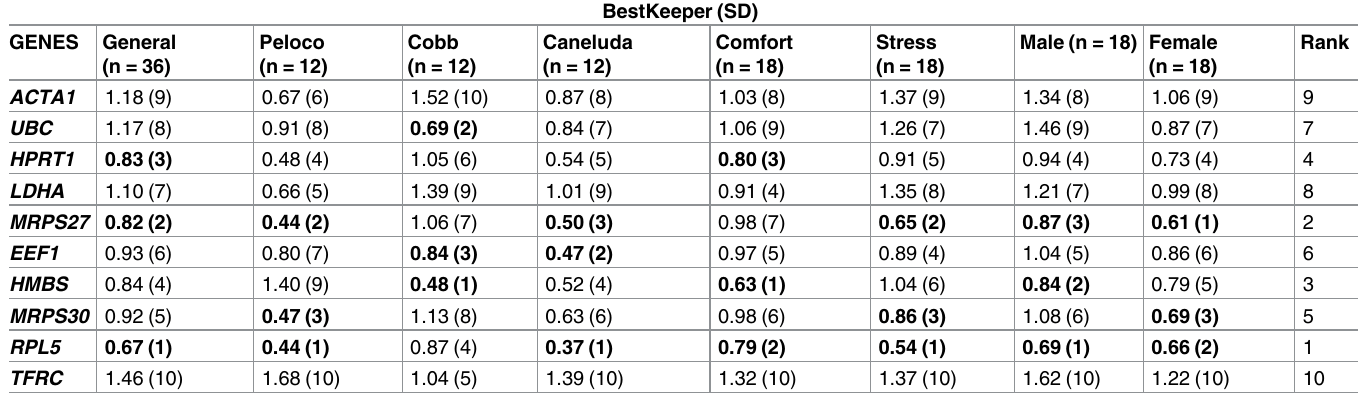
Table 7. Ranking with stability values for each treatment (genetic group, sex, and environment) in chicken obtained from BestKeepertool. Values into the parenthesis refer to ranking by Bestkeeper to each treatment. Valueson the last column refer to the rankingposition by RankAggreg packageamong all the